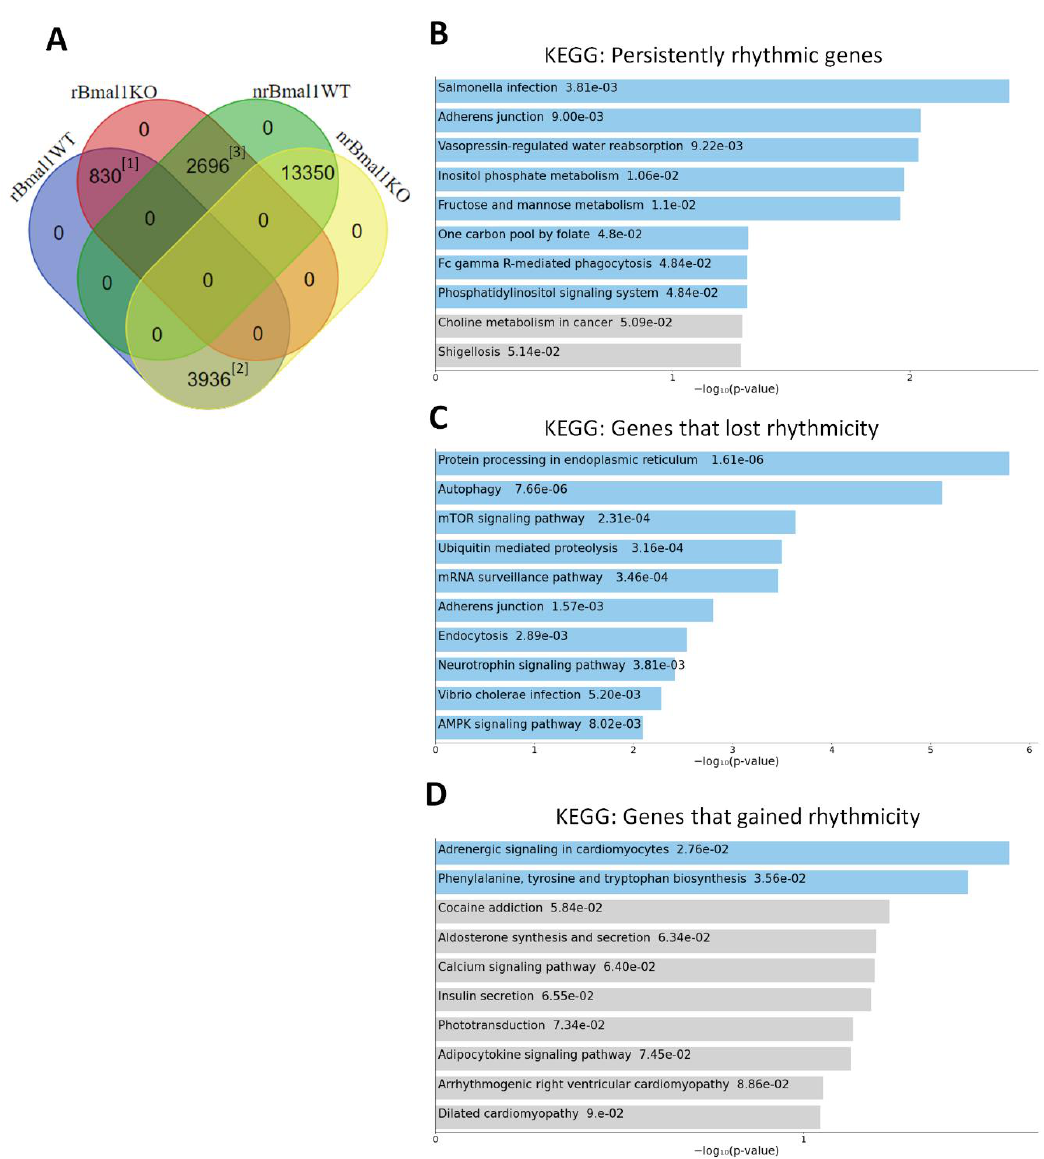
Figure 5. Effect of Bmal1 removal on the transcription of daily biological pathways. Isolated RPE samples were collected at different time points (ZT1, ZT7, ZT13, ZT19; ZT0 = light onset at 7AM) were subjected to high throughput RNA-sequencing analysis and a rhythmic analysis performed within each genotype. Taking the rhythmic (r) and non-rhythmic genes (nr) datasets, a Venn diagram analysis was carried out ( A ). This comparison analysis revealed that 830 protein coding transcripts remained rhythmic despite the loss of Bmal1 in the RPE ( A [1] ). Additionally, 3936 protein coding transcripts that were rhythmic in RPE Bmal1 WT samples loss rhythmicity in RPE Bmal1 KO samples ( A [2] ). Interestingly, 2696 protein coding transcripts that were not rhythmic in RPE Bmal1 WT samples were now rhythmic in RPE Bmal1 KO samples ( A [3] ). A total of 13,350 protein coding transcripts were identified to be non-rhythmic in both genotypes ( A ). KEGG pathway analysis indicated that the 830 protein coding transcripts are involved in RPE cell maintenance such as cell morphology, transepithelial transportation, metabolic processes, and background phagocytic processes ( B ); 3936 protein coding transcripts that lost rhythmicity in RPE Bmal1 KO are possibly involved in mediating the peak in phagocytosis of photoreceptor outer segments and turnover of engulfed outer segments ( C ); 2696 protein coding transcripts that gained rhythmicity in the absence of Bmal1 did not indicate any particular pattern of activated pathways with only 2 KEGG pathways being statistically significant ( D